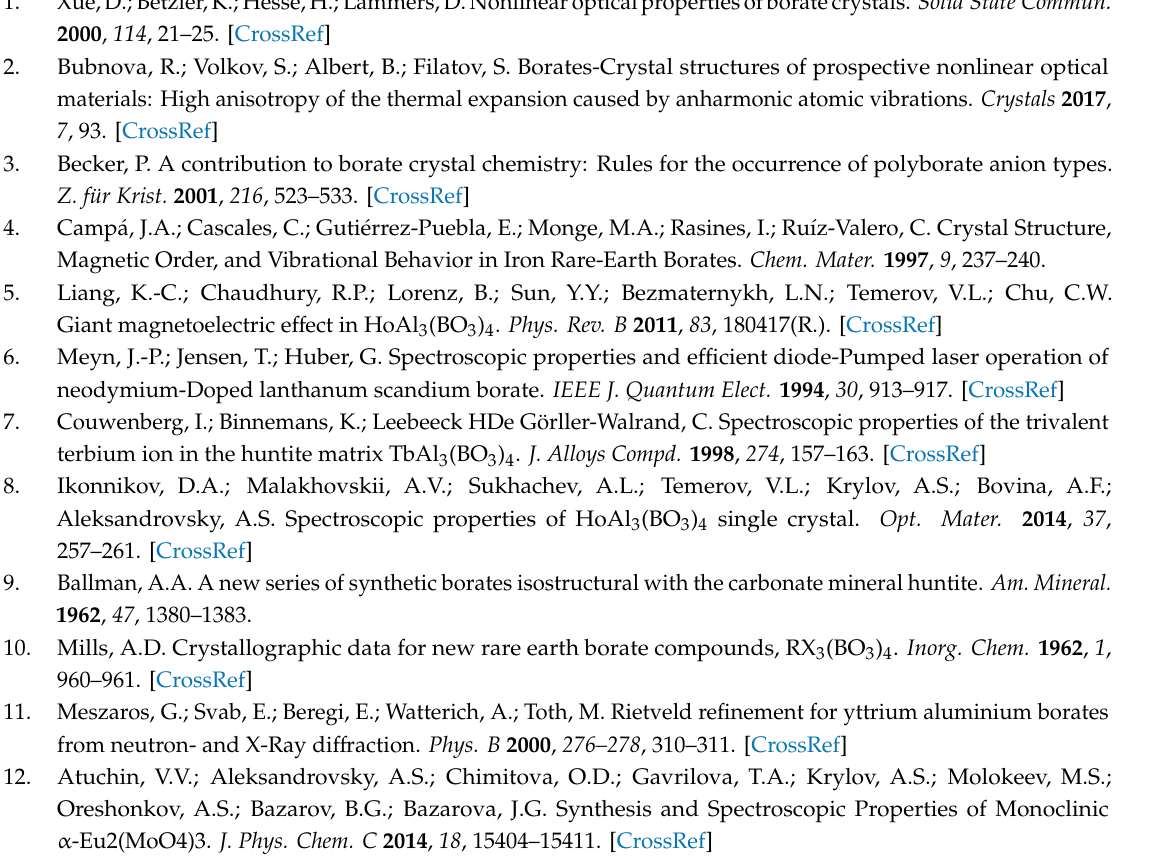
in comparison with the experimental data, Table S6: Calculated and experimental phonon frequencies (cm − 1